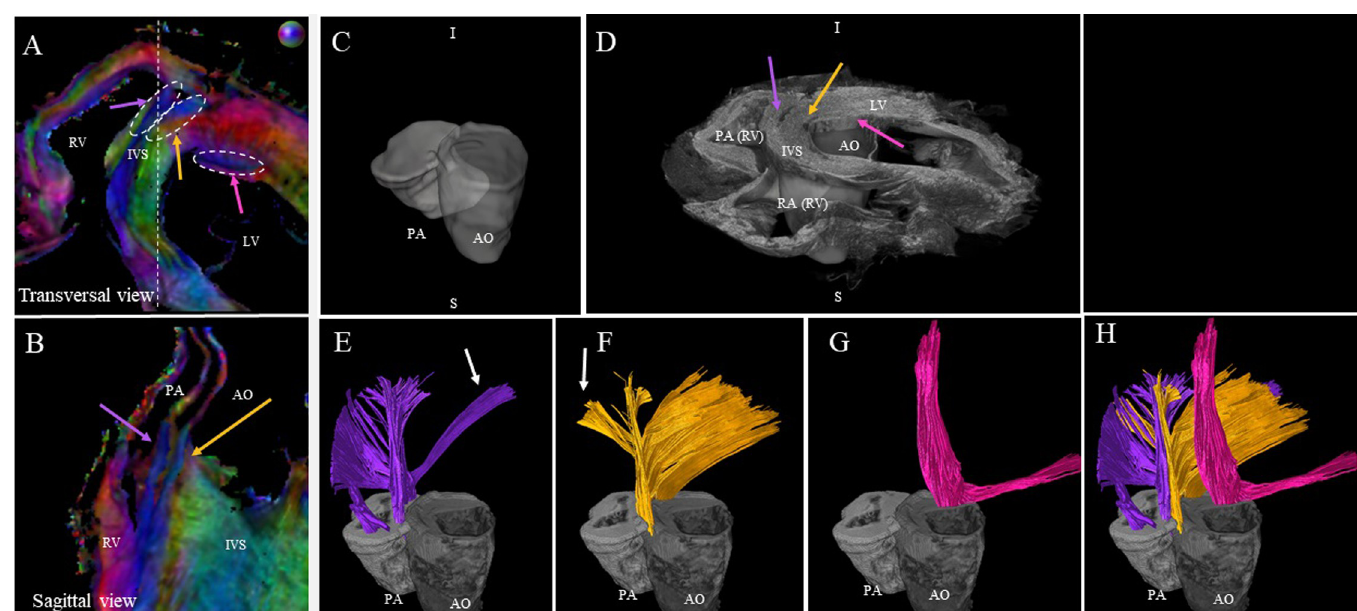
Fig 7. Tractography of the anterior junction. A) and B) zoom-view of the cFA maps of sample #1 in the anterior junction in the basal area in transversal and sagittal orientation, respectively. Three regions of interest are identified: a fascicle of streamlines coming from the IVS splits into two branches going on one side to the wall of the pulmonary artery (purple arrow) and, on the other side to the wall of the aorta (yellow arrow). The third fascicle of streamlines, located in the LV, goes from the aorta to the papillary muscles (pink arrow). C & D) 3D rendered images of the anatomical template with the superimposed mesh of the PA (white) and the AO (gray) Note that the volume was flipped and this orientation was kept for all following representations. E, F, G, H) For each region, seeds were manually defined, then streamlines were computed using the template diffusion tensor without ROI restriction.